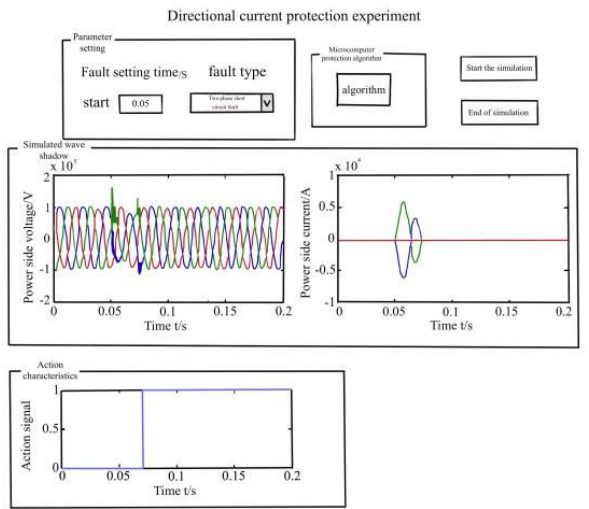
Figure 11: Voltage, current and action signals of power supply eA